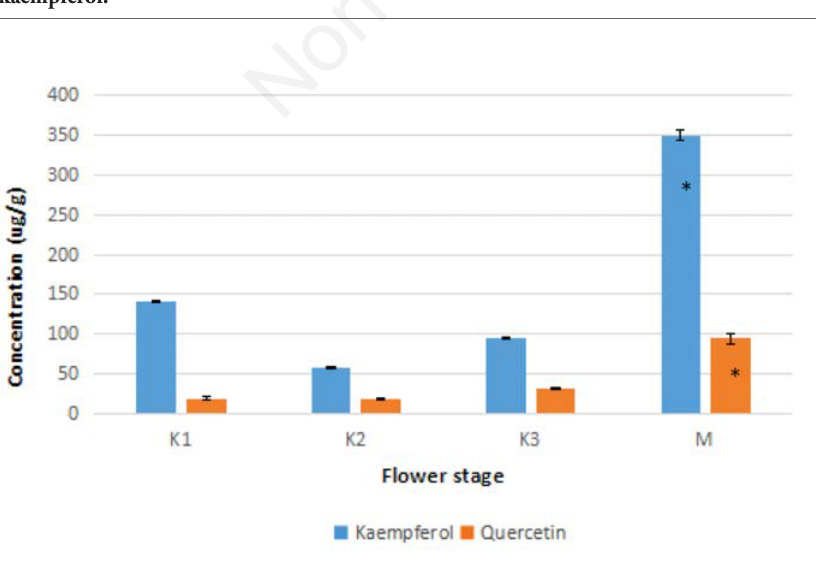
Figure 6. Levels of quercetin and kaempferol in various phases of flowering.